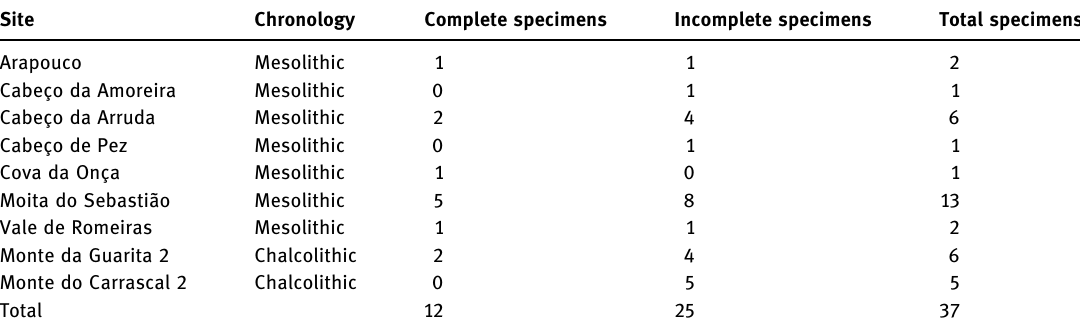
Table 1: Inventory of complete and incomplete specimens ( per site and chronology ) used in this study